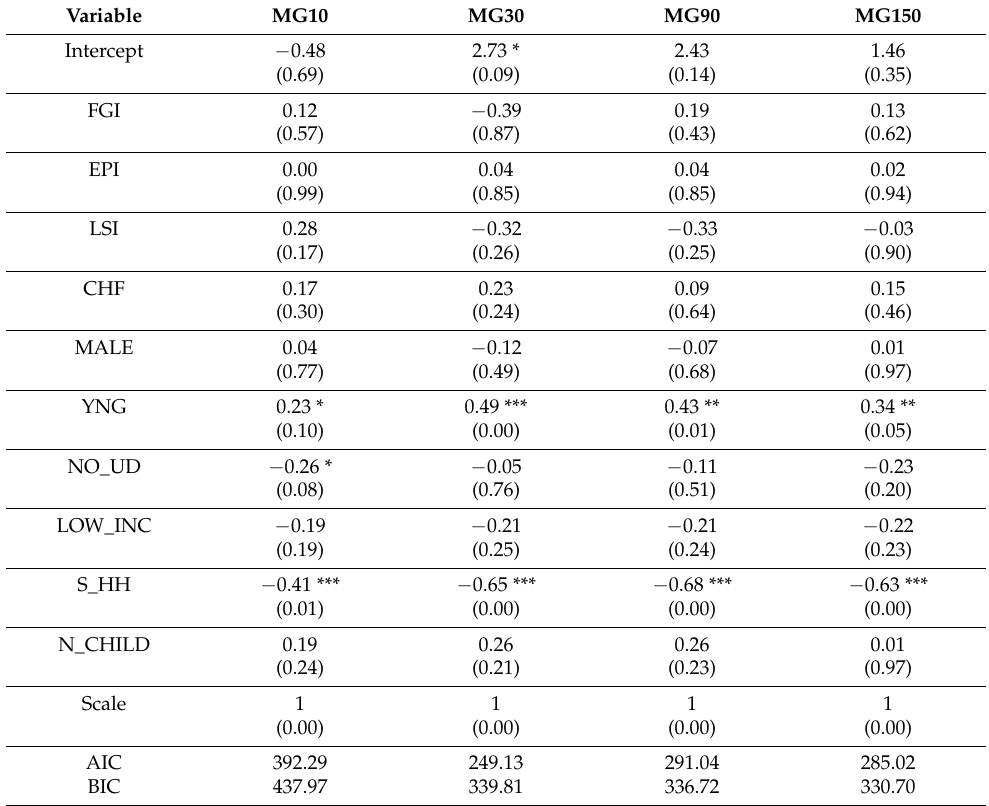
Table 5. Parameter estimates, standard errors (in parentheses) and goodness-of-fit statistics for monetary gains for delays separately (binomial model, logit link function, base state of explanatory variable: DR >